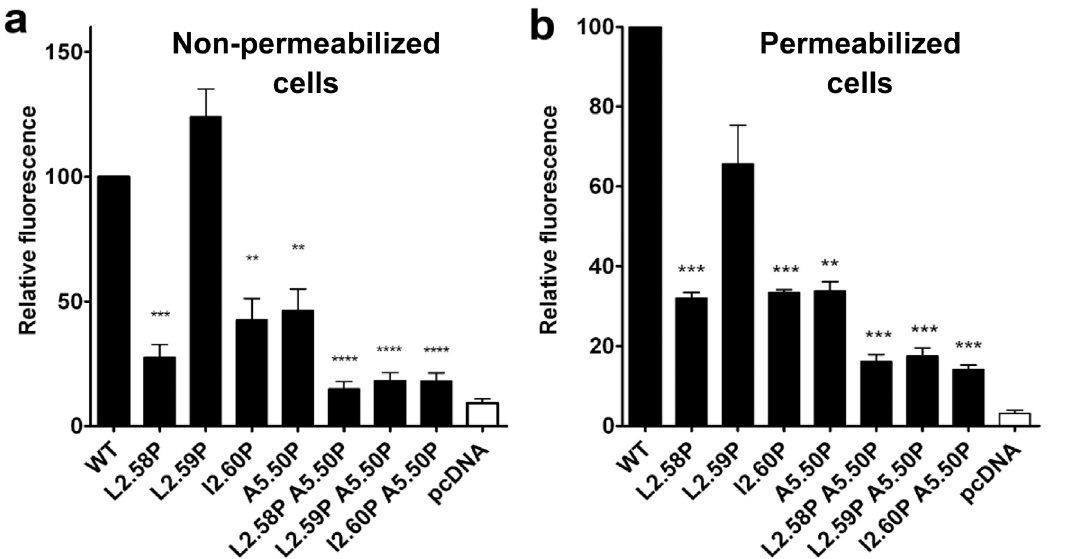
Fig 3. Expression of the TSHR mutants. (a) Cell surface expression and (b) total cell expression of WT and mutated TSHRs, given as the percentage of the wild type control, after transfection of HEK-293 cells by the same amount of TSHR coding pcDNA3.1 plasmid. Receptor expression was determined by flow cytometry measurements of intact (a) or permeabilized cells (b). The histograms represent the mean ± SEM of at least 3 independent experiments, each carried out in